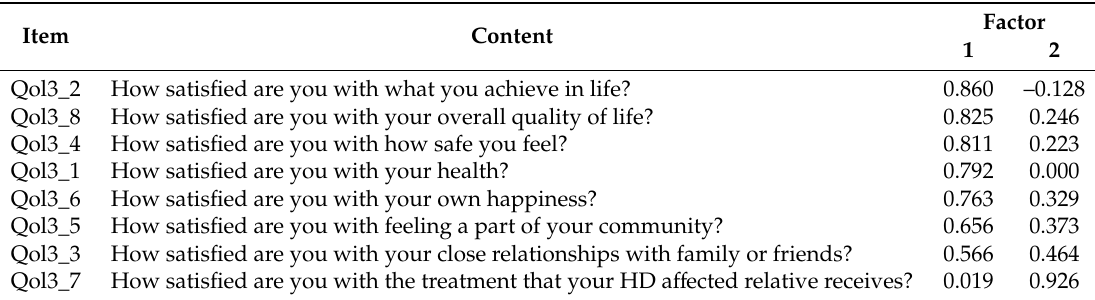
Table 3. Pattern Matrix of rotated factor loadings for section